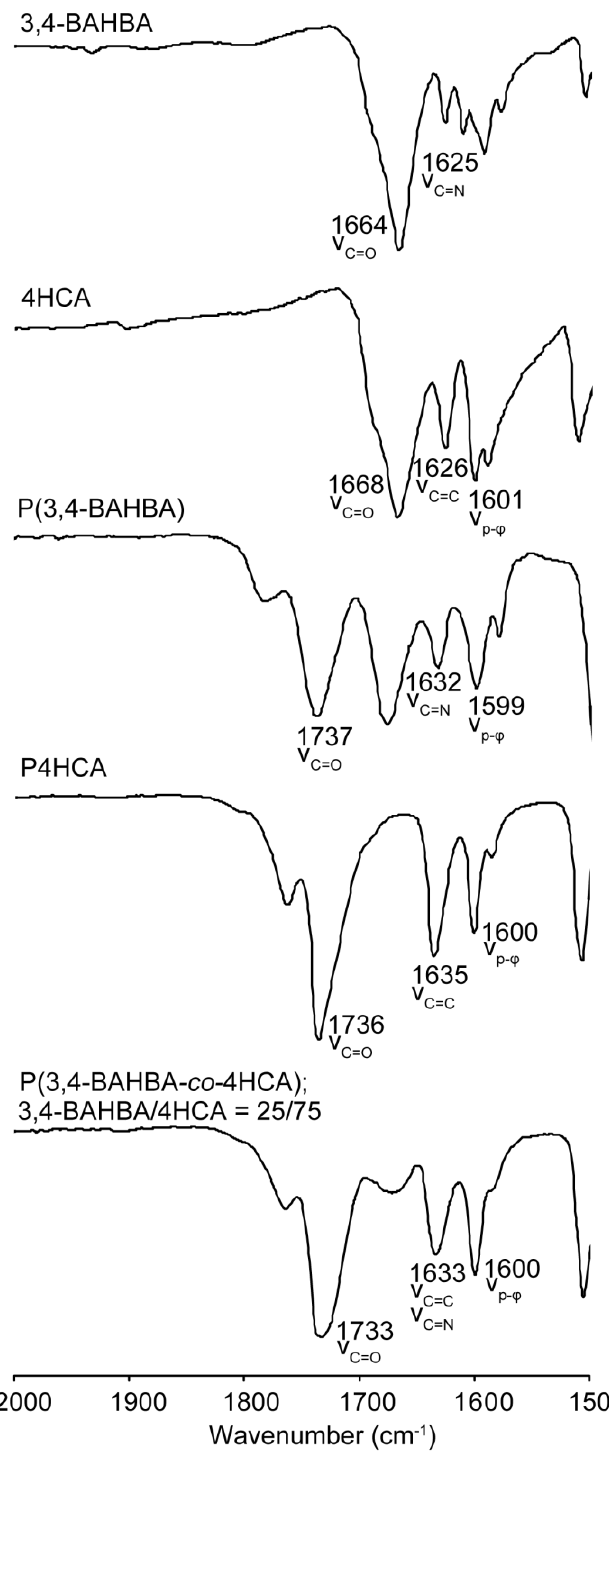
Figure 1. FT-IR spectra of the monomers and